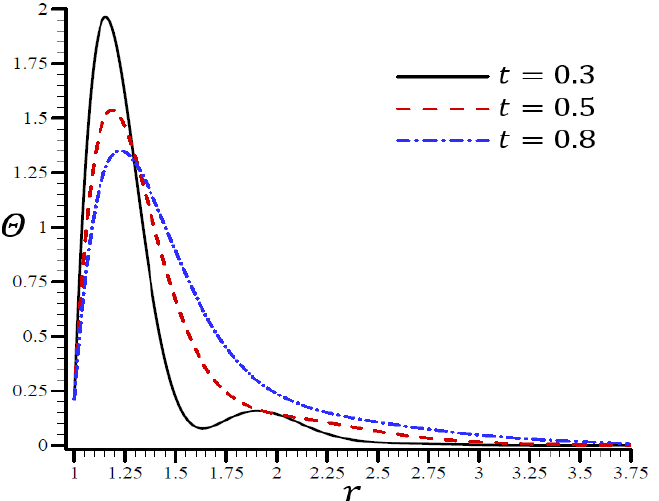
Figure 7. The influence of t on temperature Θ through the radial direction of a spherical hole using the RTPL model.